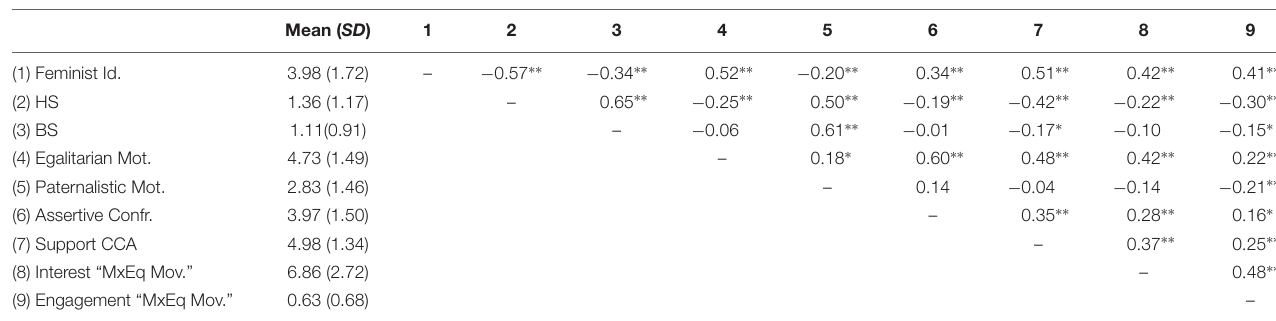
TABLE 2 | Means, standard deviations, and correlations for Study